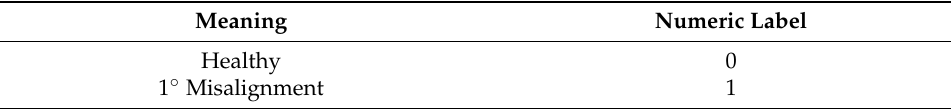
Table 1. Numeric labels in the dataset and their meanings.